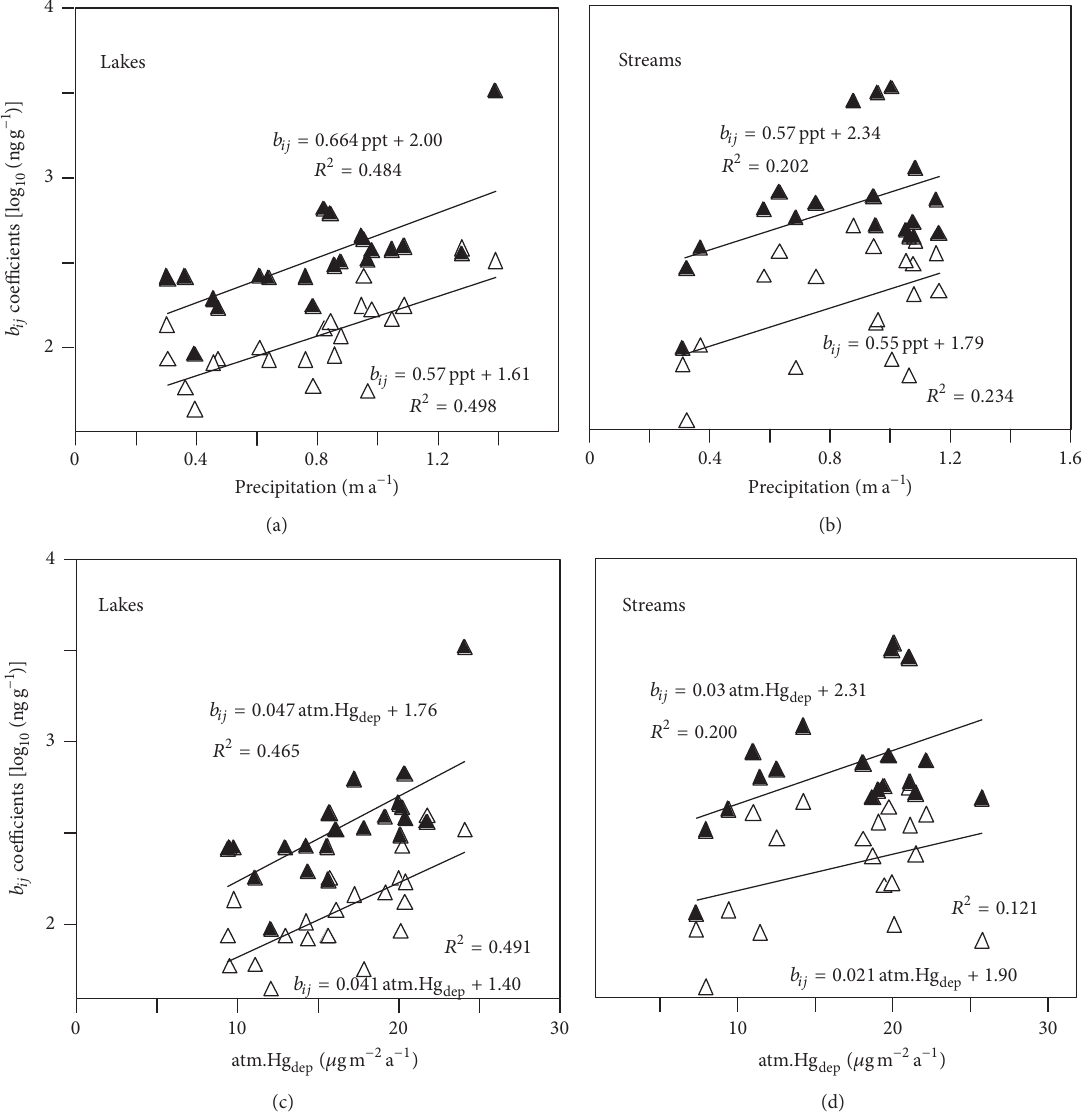
Figure 10: Scatterplots of best-fitted 𝑏 𝑖𝑗 coefficients for the 10th and 90th log 10 THg [log 10 (ngg −1 )] versus (i) mean annual precipitation rate (precipitation, ma −1 ; (a and b)) and (ii) GRAHM2005 mean annual net atmospheric Hg deposition rate (atm . Hg by provinces/territories and by Quebec survey zones, based on Table